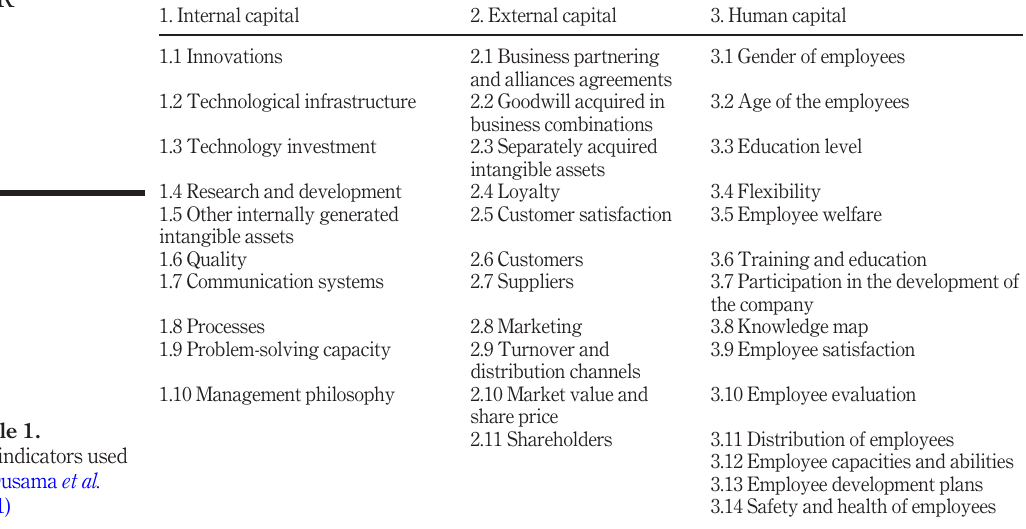
by Ousama et al.